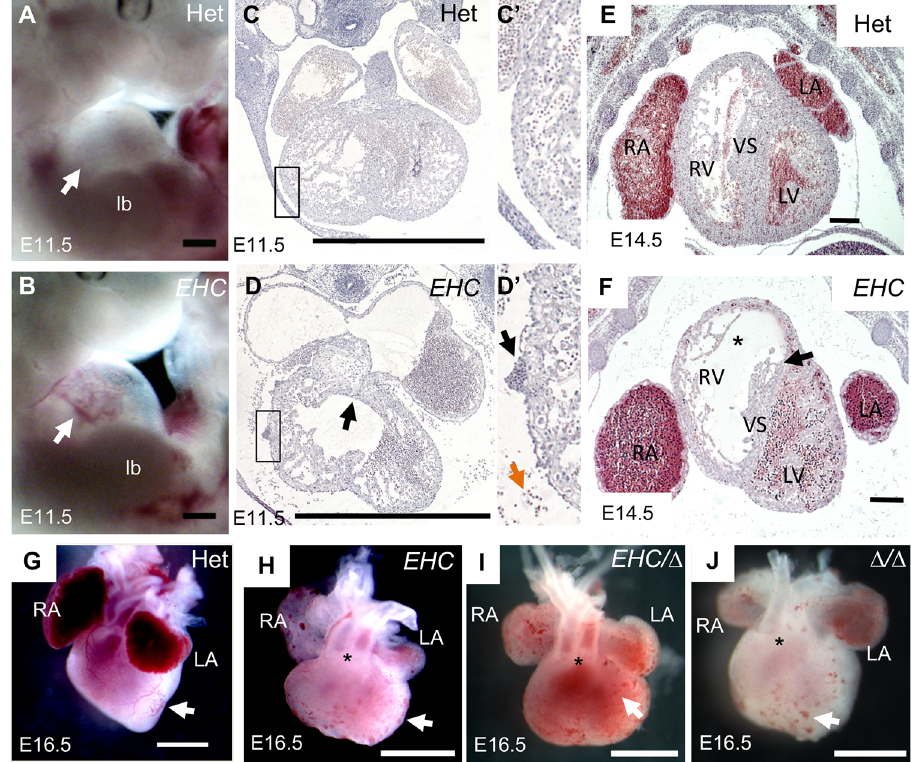
Fig 4. EHC mutants display defects in cardiac development. A: Heterozygous littermate control at E11.5 showingdeveloping heart in pericardialsac. B: EHC mutant has pericardialeffusion and blood visiblein pericardialsac (arrow). C: Transverse section of control littermate at E11.5. The boxed regionindicatesthe segment shown in panel C’. C’: Note the absenceof blood cells on the cardiac surface and in the pericardial space. D: Transverse section of EHC mutant at E11.5 showingenlargedatria. The boxed regionindicatesthe segment shown in panel D’. D’: Blood cells are present on the surface of the EHC heart (black arrow) and in the pericardial space (orangearrow). E: In heterozygous littermates at E14.5 the ventricular chamberis surroundedby a thick compact myocardium, which is highly organised. F: At E14.5, EHC mutants show a reducedcompact ventricular myocardium(indicated by asterisk), accompaniedby a thinningof the ventricular septal tissue (arrow). Note the abnormalatrial morphologyand different localisation of the atria with respect to the ventriclecomparedto control (E). G: Heterozygous heart at E16.5 shows expectedventricular vascular connections and also coronaryvessels on the cardiacsurface (arrow). H: EHC mutant heart shows double- outlet right ventricle(DORV) (asterisk) as well as an absenceof surface coronary vessels (arrow). Note the vesicle-likestructures present on the ventricular surface. I: EHC / Myh10 Δ and J: Myh10 Δ / Myh10 Δ hearts at E16.5 similarlyshow DORV (asterisks) and ventricular vesicles (arrows). Scale bar = 200 μ m (E, F), 1mm (A-D, G-J). Abbreviations: Het: heterozygote; lb: limb bud; LA: left atria, LV: left ventricle, RA: right atria, RV: right ventricle, VS: ventricular septum, Δ : Myh10 Δ